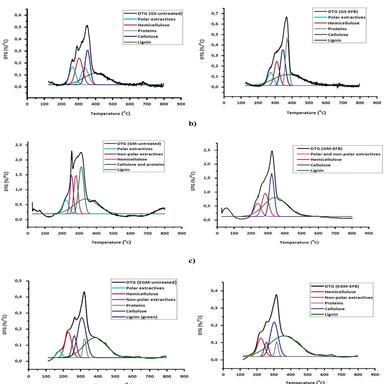
Differential thermogravimetric (DTG) curves deconvolution for grape stalks (GS) (a), grape marc (GM) (b) and exhausted grape marc (EGM) (c): untreated and extractives-free biomass (EFB) derived.